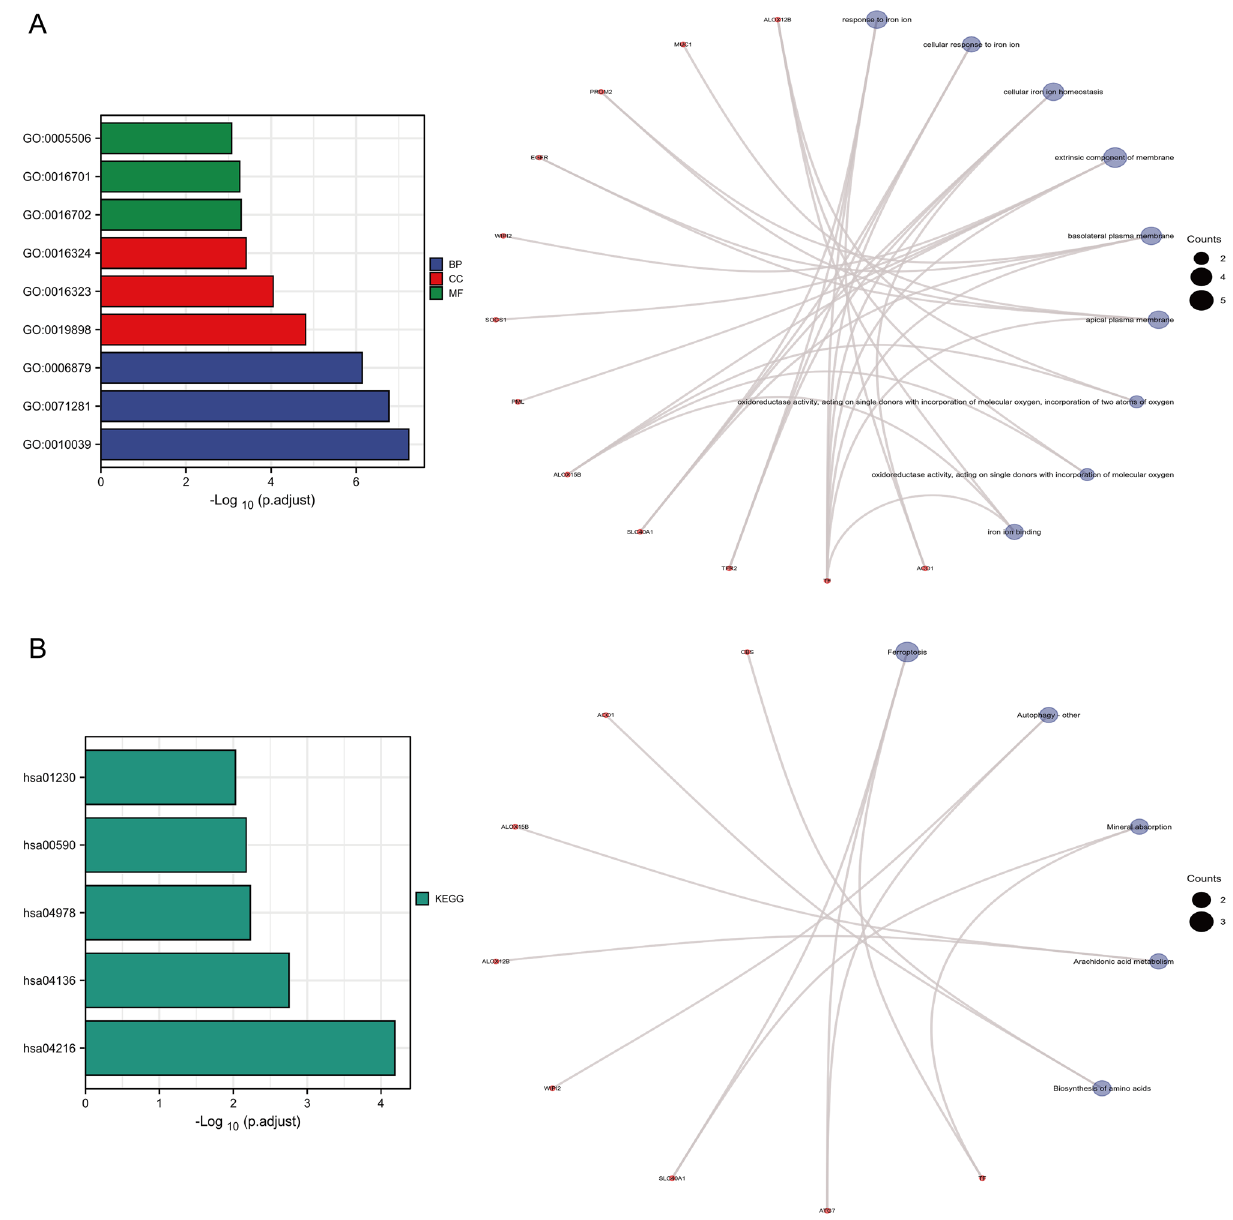
Figure 3. GO and KEGG enrichment analyses of ferroptosis-related DEGs. ( A ) GO enrichment analysis visualization network based on the top-three most significant-enriched terms in each of the BP, CC, and MF entries. ( B ) KEGG enrichment analysis visualization network based on the top-five most significant-enriched